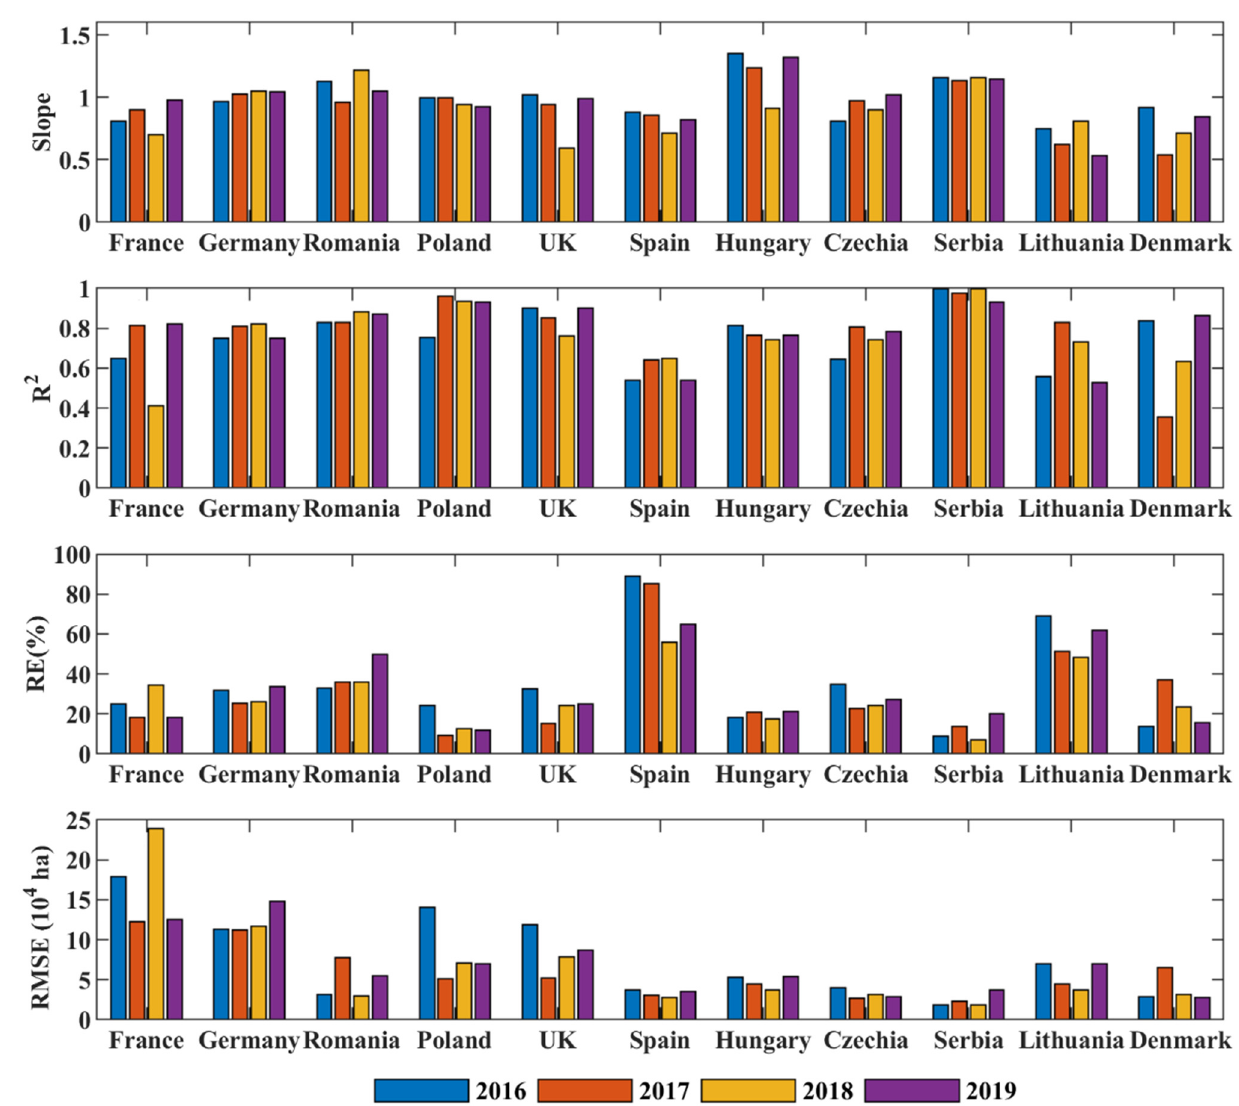
Figure 6. The relationship between the identified and statistical winter cereal areas at the municipal level for 2016–2019.